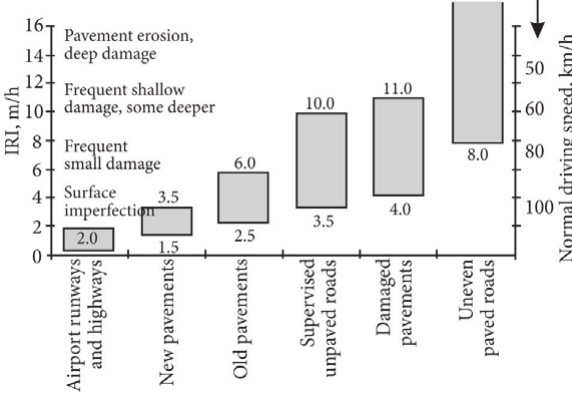
Fig. 1. IRI values for different road pavements (Sayers et al. 1986)